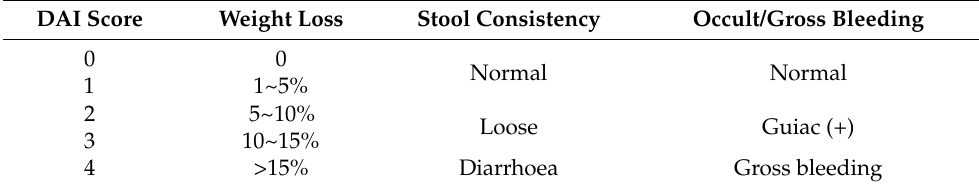
Table 1. DAI scoring